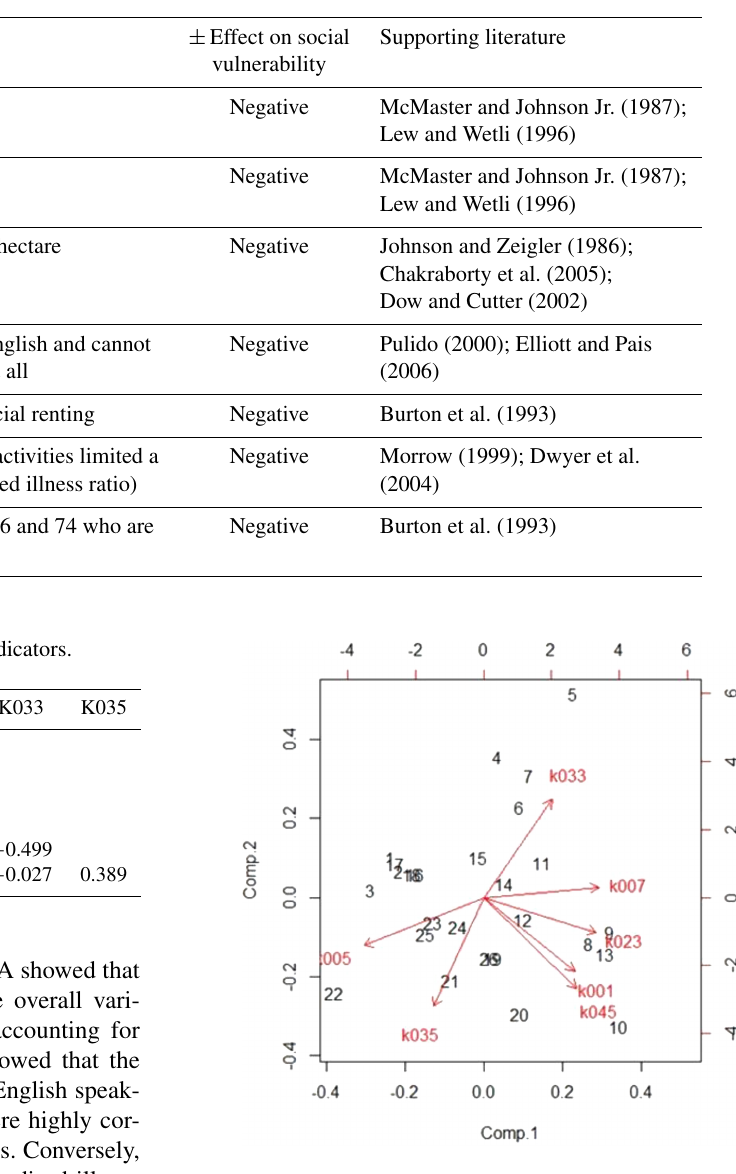
Figure 2. Biplot of component